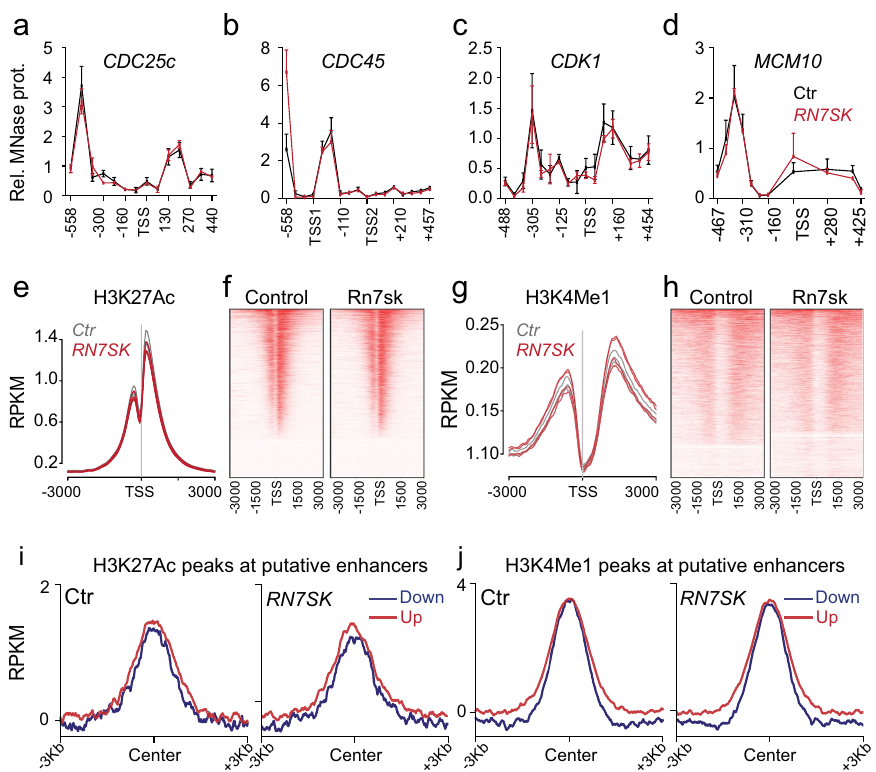
Fig. 5 Chromatin at enhancers and promoters is unaltered in RN7SK knock-down cells. a – d Micrococcal Nuclease (MNase) protection assay around the transcriptional start sites (TSS) of four downregulated candidate genes showing nucleosome distribution in control (Ctr) (black lines) and RN7SK knock- down (red lines) cells 24 h after siRNA transfection ( n = 4 transfections). Data are presented as mean values ± SD. e – h Occurrence of H3K27Ac ( e ) and H3K4Me1 ( g ) ±3000 bases from the TSS in Ctr (grey) or RN7SK knock-down (red) cells ( n = 4 ChIP-seq experiments). Representative heatmaps ( f , g ) showing sequencing reads from data in ( e , g ). i , j Distribution of H3K27Ac ( i ) or H3K4Me1 ( j ) ChIP seq signal ±3000 bases from the enhancer centre in up- (red) or downregulated (blue) genes in 4SU RNAseq dataset (padj < 0.05, Log 2 Fc > 0.3 or < − 0.3) in Ctr (left hand panels) or RN7SK knock-down (right hand panels) cells. Shown is one representative ChIP-seq experiment out of four replicates. Source data are provided as a Source Data fi